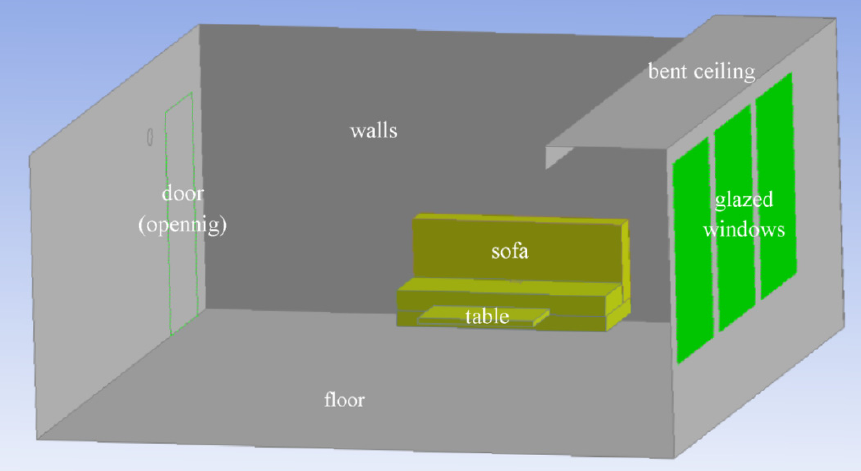
Figure 8. A Fluent model of the partially furnished compartment.